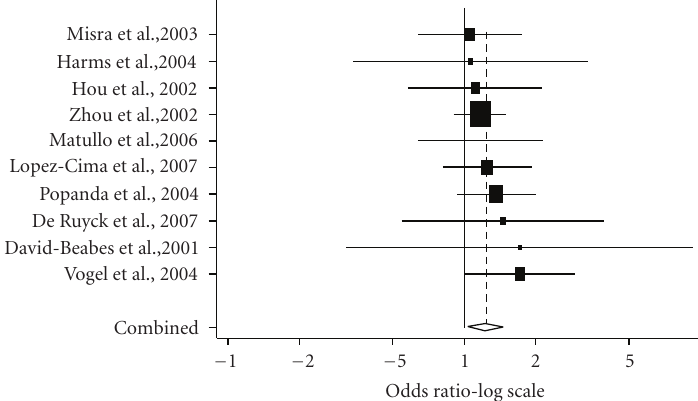
Figure 2: Meta-analysis of 10 Caucasian studies of lung cancer and the ERCC2 Lys751Gln polymorphism (Gln/Gln versus Lys/Lys). The center of a box and the horizontal line (logarithm) indicate the odds ratio (OR) and the 95% confidence interval (CI) in each study, with the areas of the boxes representing the weight of each study. The summary OR based on random e ff ects model is represented by the middle of a diamond whose width indicated the 95% CI. The summary OR is shown by the dotted vertical line. Statistical heterogeneity between studies was assessed with Cochran Q test( Q = 2 . 75, P = . 97). Summary: OR = 1.24 (95% CI =